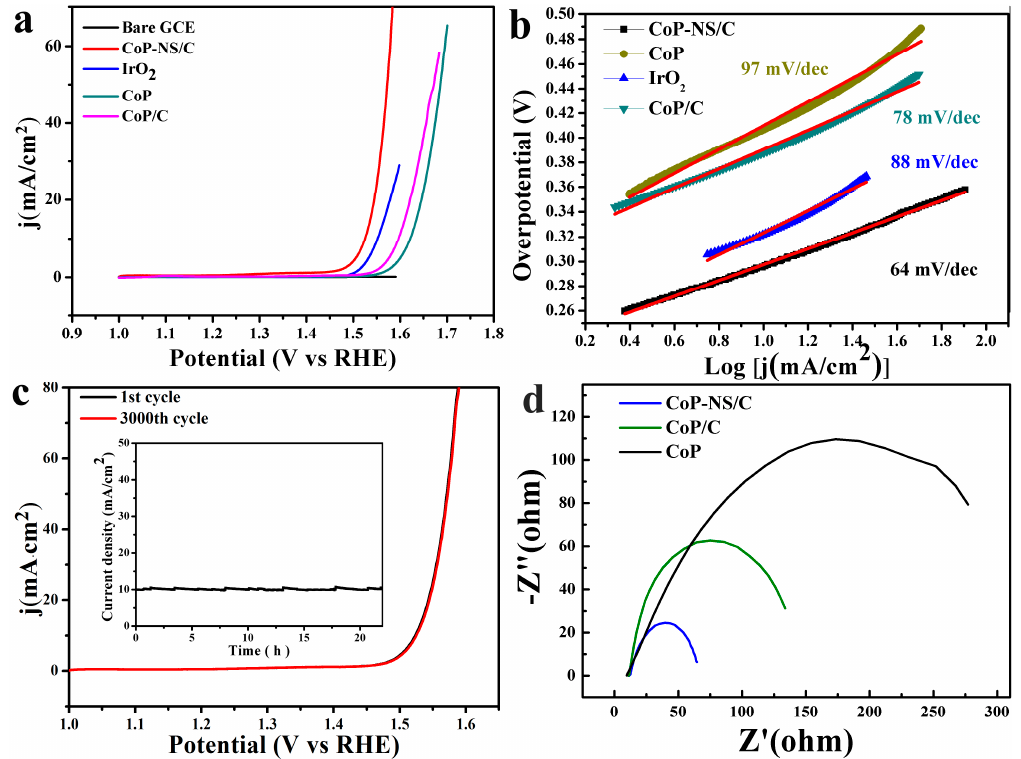
Figure 4. ( a ) IR-corrected polarization curves of CoP-NS/C, CoP/C, CoP, bare GCE, and IrO 2 for OER in 1 M KOH at a scan rate of 10 mV/s; ( b ) Tafel slopes of CoP-NS/C, CoP/C, CoP, and IrO 2 ; ( c ) durability test for the electrochemical OER of CoP-NS/C (inset: time-dependent current density curve of CoP-NS/C under static overpotential of 292 mV); and ( d ) Nyquist plots of the CoP-NS/C, CoP/C and CoP at a current density of 10 mA/cm 2 in 1 M KOH solution.